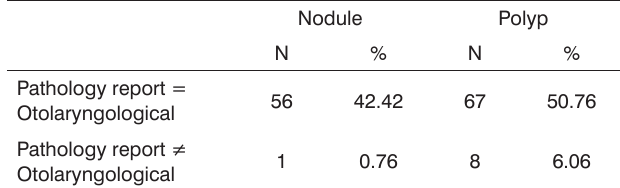
Table 3. Comparison between the ENT and the pathology diagnoses of vocal fold nodules and